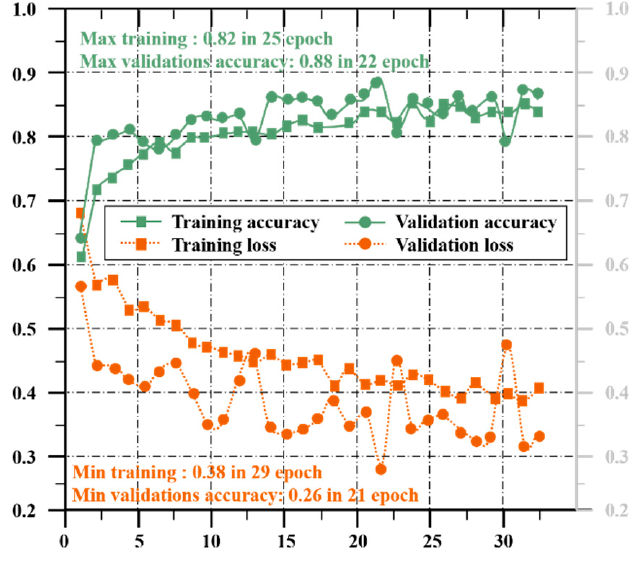
Figure 9. Accuracy and loss values in each epoch.